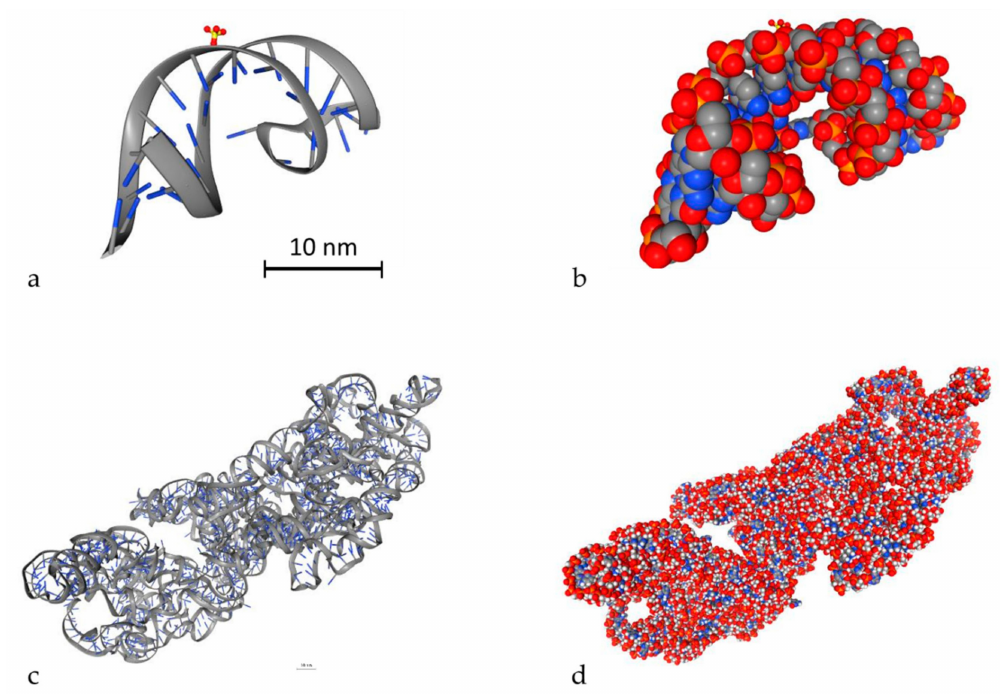
Figure 3. 3D view of two di ff erent DNA molecules by the Proteins Data Bank (PDB) database. Scale bars have been added accordingly. Both scale bars represent a distance of 30 nm. ( a ) Simple small DNA, stylish view, ( b ) simple small DNA, “simulation” view, ( c ) complex DNA, stylish view, ( d ) complex DNA, “simulation”